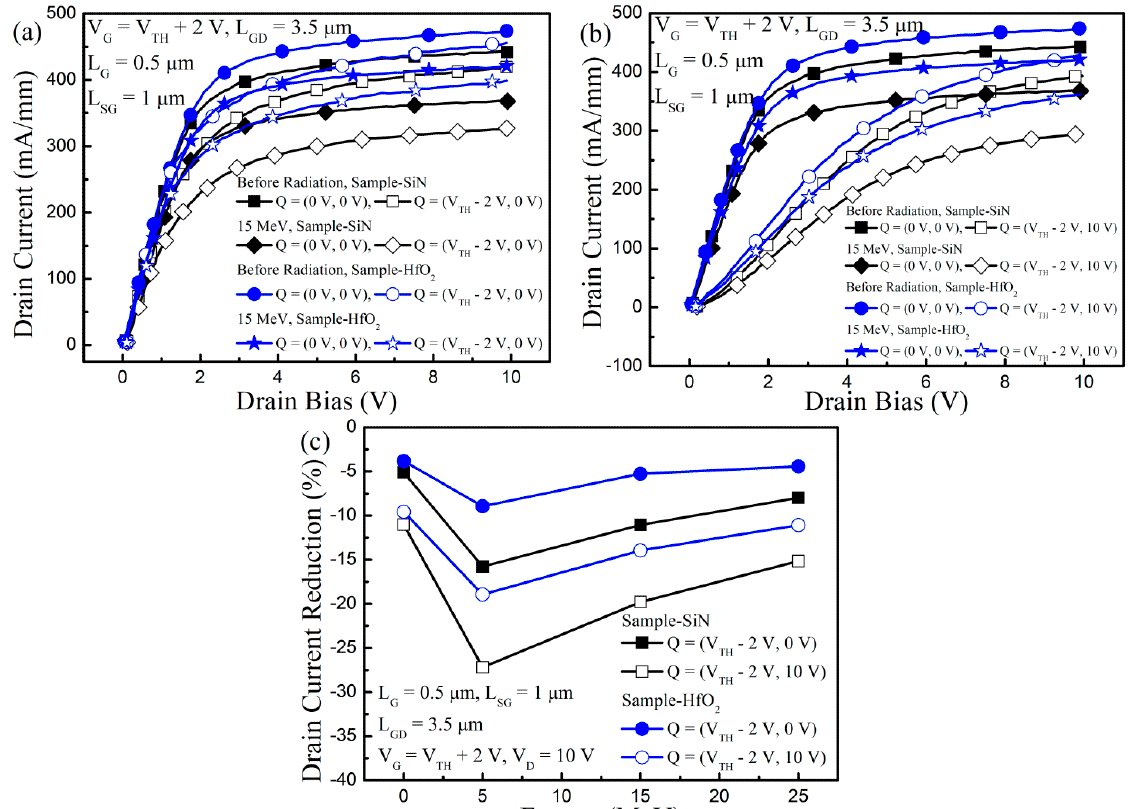
Figure 5. Pulse-mode stress measurement results in GaN-based MIS-HEMTs for the 5 nm-thick Si 3 N 4 and the HfO 2 gate insulator. Drain current versus drain bias with the quiescent bias of: ( a ) (0 V, 0 V) and (V TH − 2 V, 0 V); ( b ) (0 V, 0 V) and (V TH − 2 V, 10 V) before and after proton irradiation at the energy at 15 MeV; ( c ) drain current reduction from the quiescent bias of (0 V, 0 V) induced by the pulse-mode stress with the quiescent bias of (V TH − 2 V, 0 V) and (V TH − 2 V, 0 V) as a function of irradiated proton